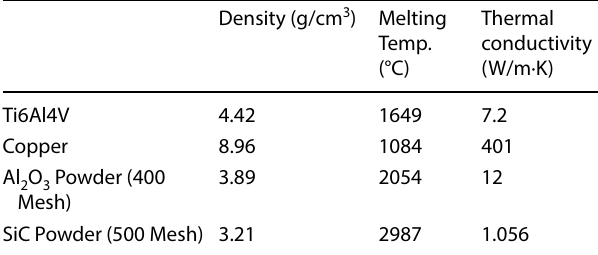
Table 2 Workpiece and tool electrode properties